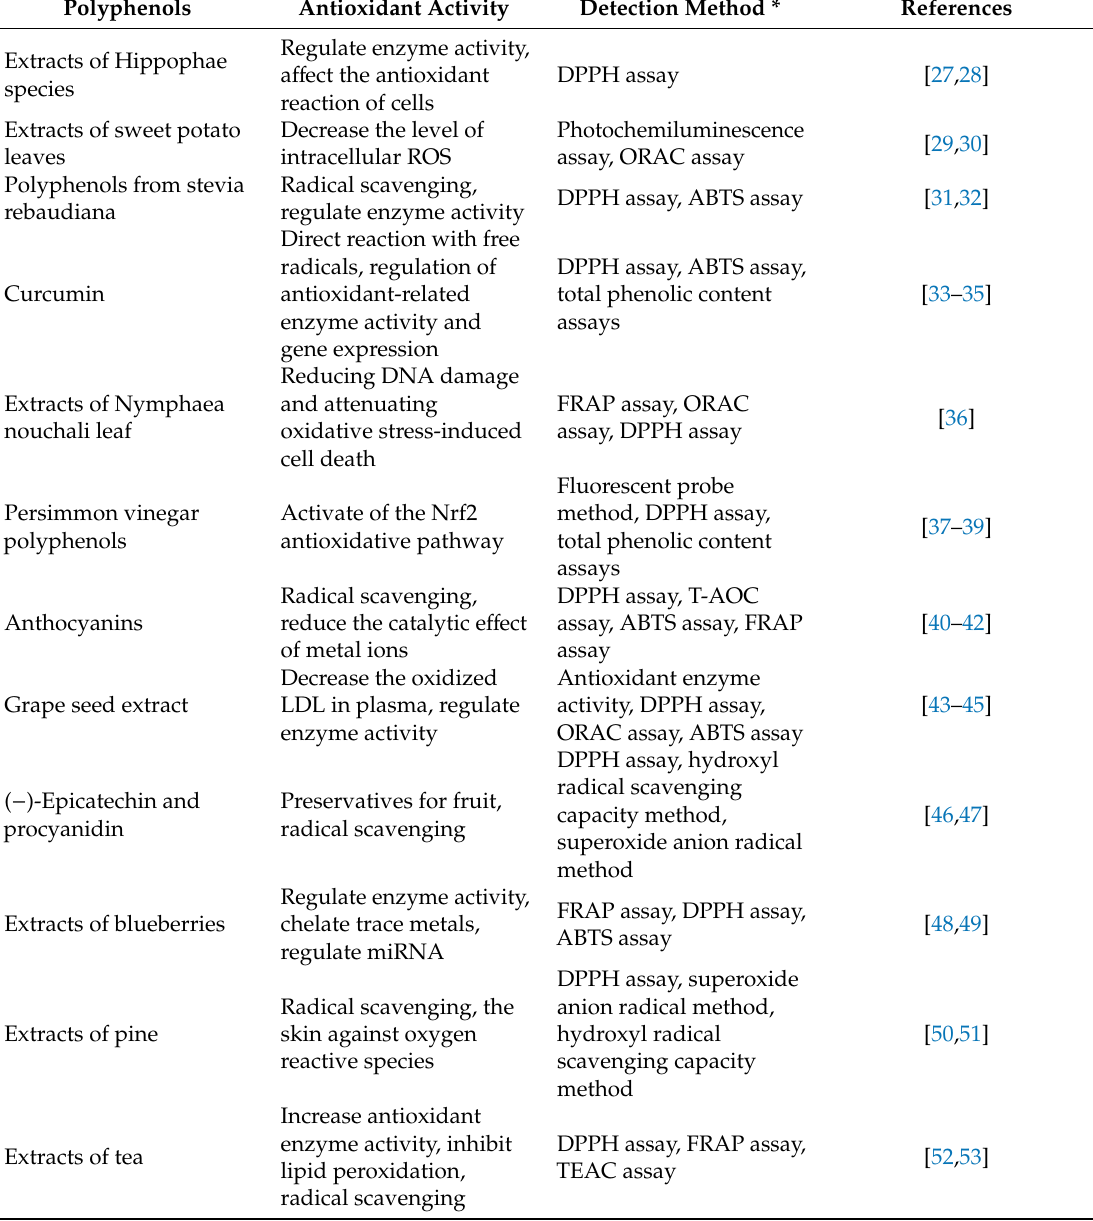
Table 1. Antioxidant activities of some extracts / compounds from